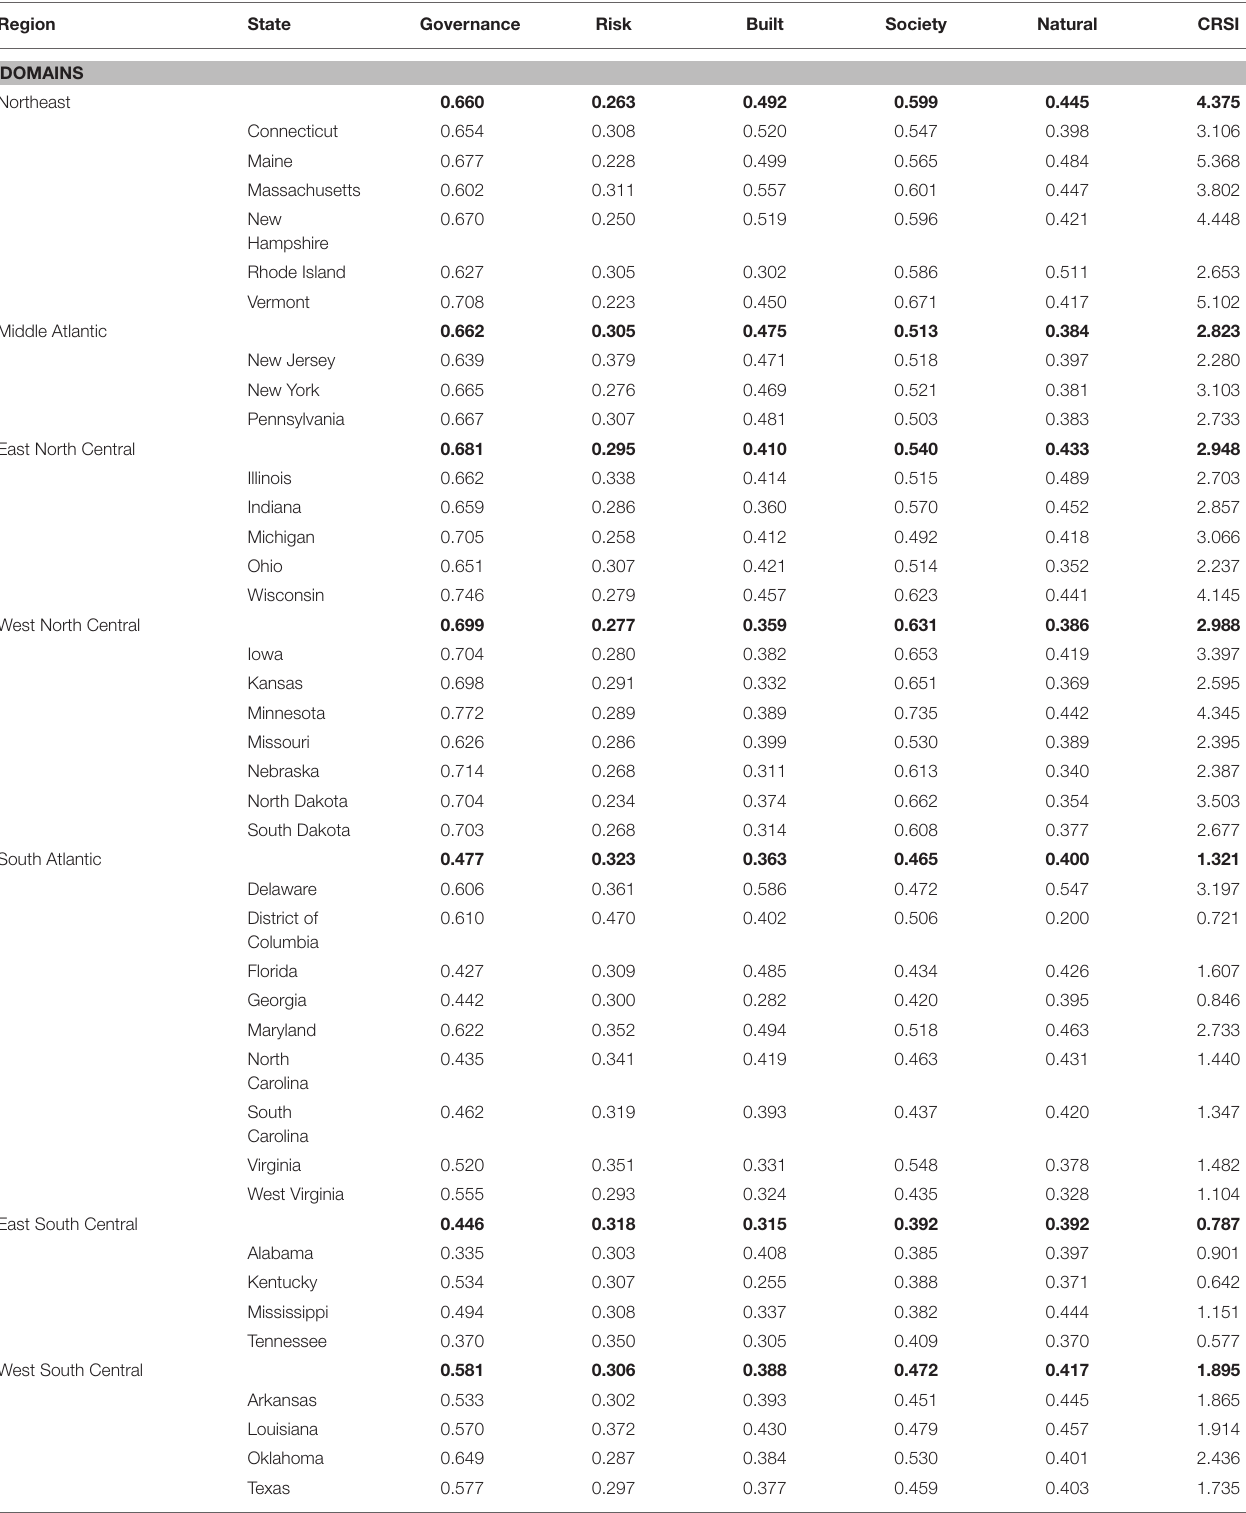
TABLE 2 | Regionalized CRSI scores and domain scores by region and state.